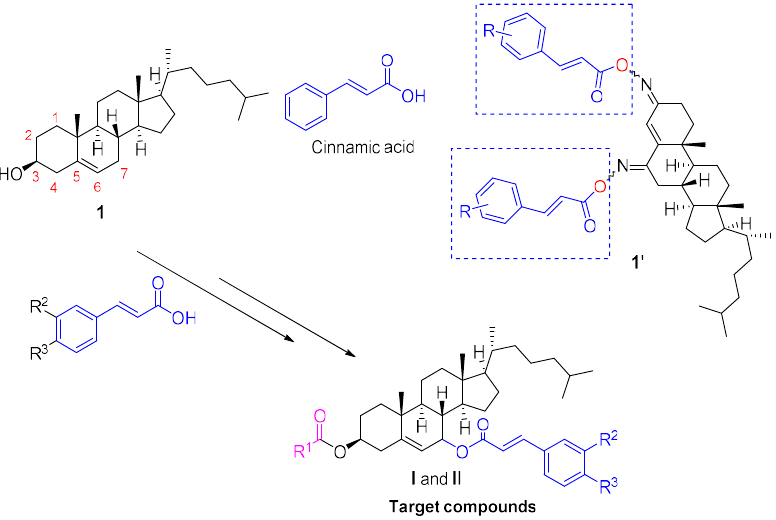
Figure 1. Design of cholesterol esters derivatives I and II.